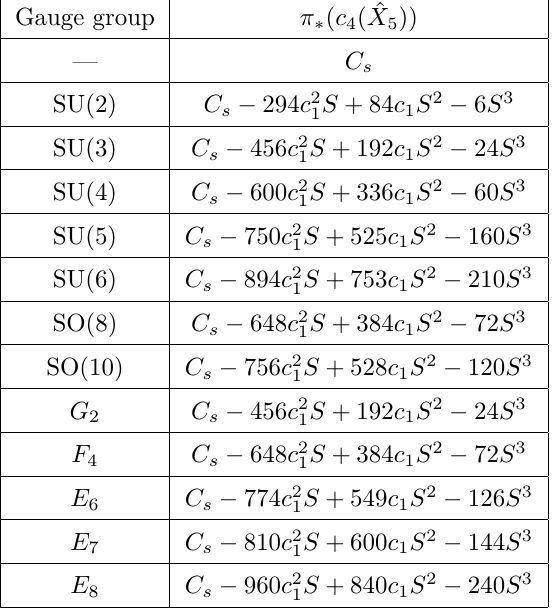
Table 6 . The values of π ∗ ( c 4 ( ˜ X 5 )) in the gravitational anomaly formula. c k denotes the k th Chern class of the base B 4 . We set C s = 360 c 3 1 + 12 c 1 c 2 for convenience.